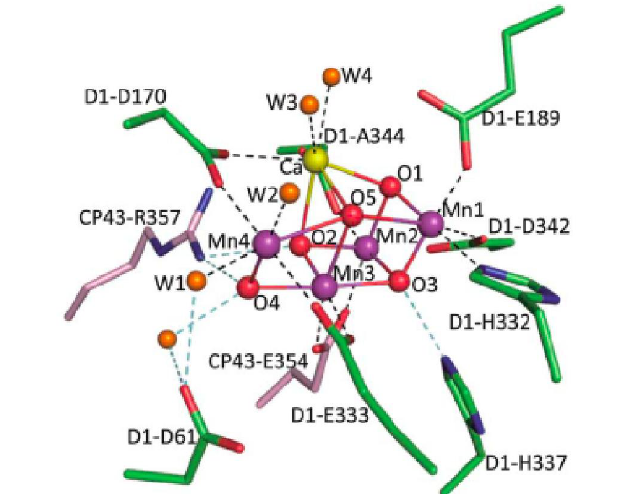
Figure 1. Structure of the Mn CaO cluster and its ligand environment in photosystem II 4 5 oxygen-evolving complex at a resolution of 1.9 A. (from reference [28], produced with permission from Macmillan